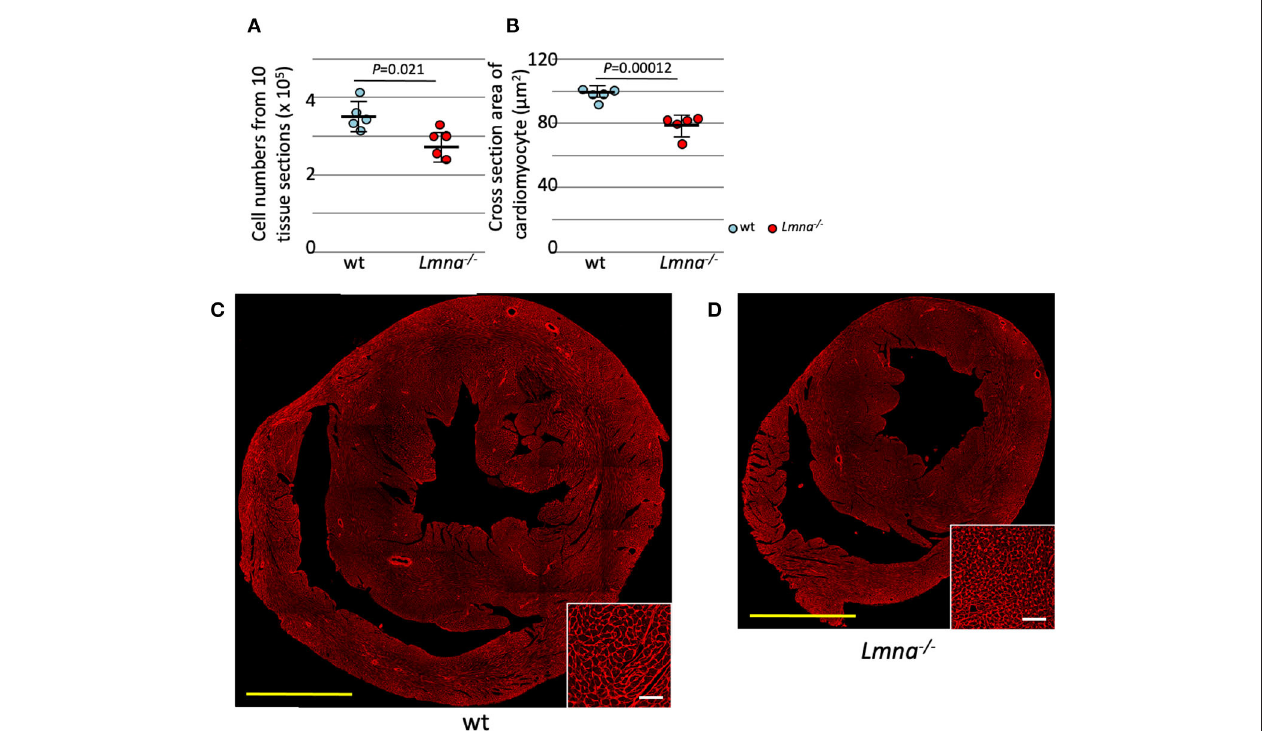
FIGURE 1 | Cardiomyocyte cell number and size in wild type (wt) and Lmna − / − mice. Both the cell number and size of cardiomyocytes were significantly reduced in Lmna − / − mice (3 weeks old). (A) Total counts of cardiomyocytes in 10 tissue layers of the heart ( n = 5 in each group). (B) Cross-section area of cardiomyocytes measured in a tissue section ( n = 5 in each group). (C,D) Tissue sections stained with wheat germ agglutinin in wt (C) and Lmna − / − (D) mice. The open circle represents wt, and the solid circle represents Lmna − / − mice. The significance of differences between two groups was determined using the Student’s 2 tailed T -test. Scale bar: 1mm in lower magnification and 50 µ m in higher magnification in inset.